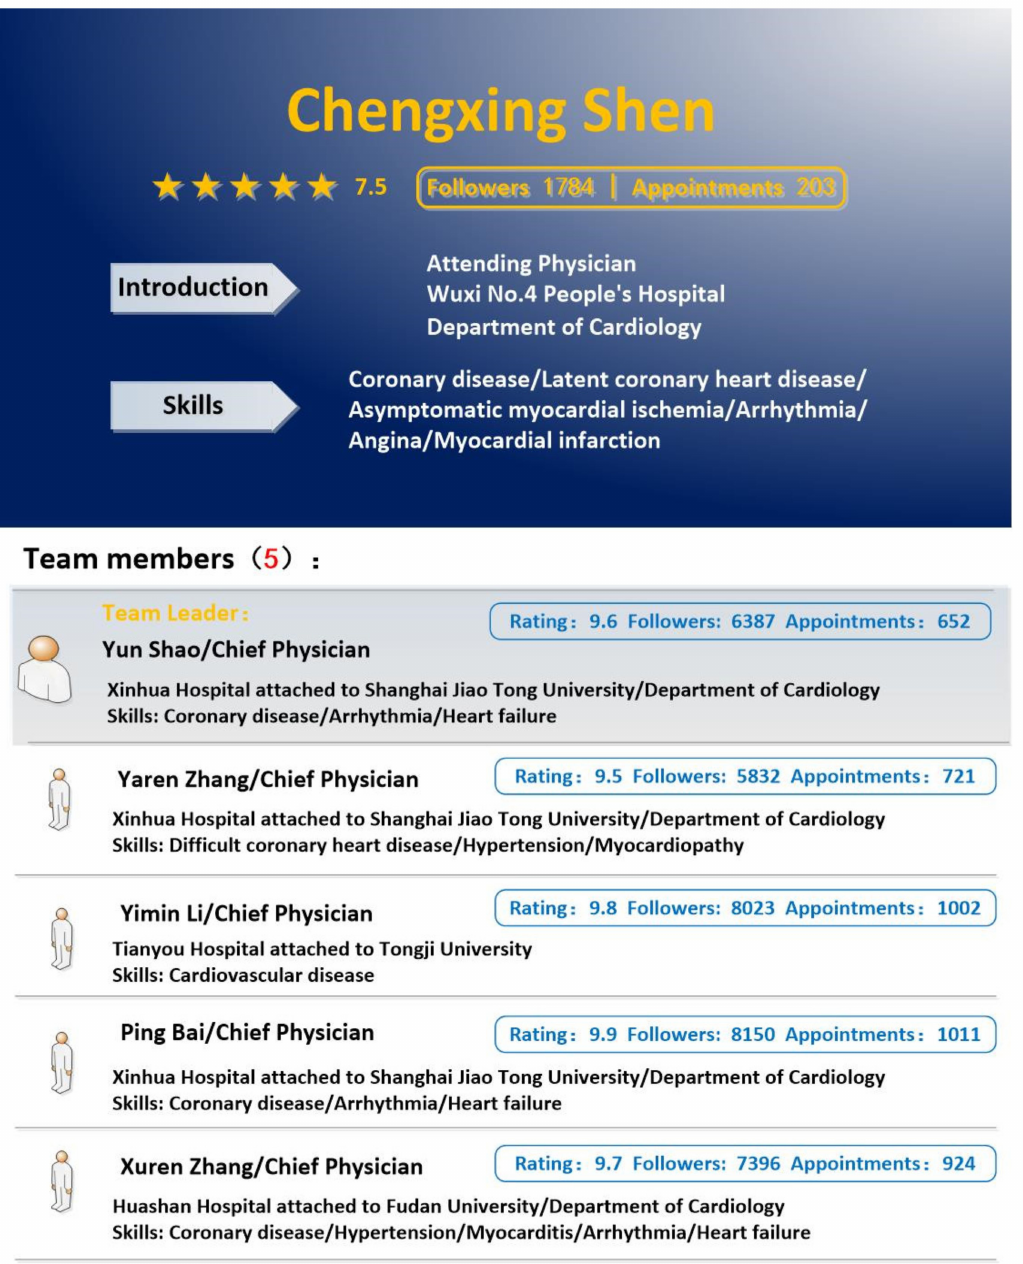
Figure 3. The description of the physician who joined a